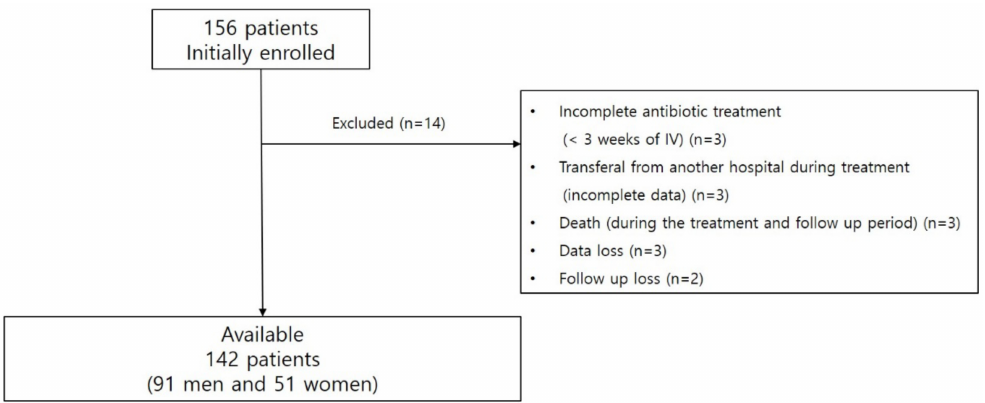
Figure 1. Flowchart of inclusion and exclusion process of PSI patients.